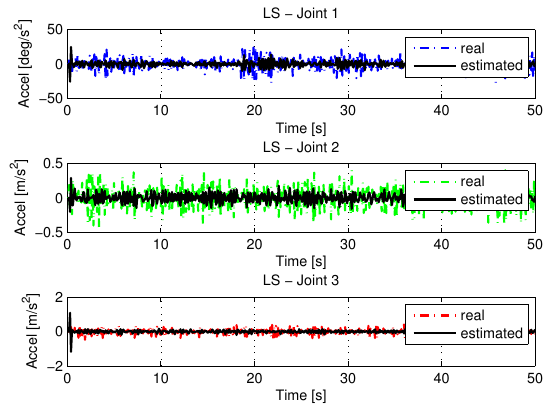
Figure 25. Accelerations of joints with LS with noise.